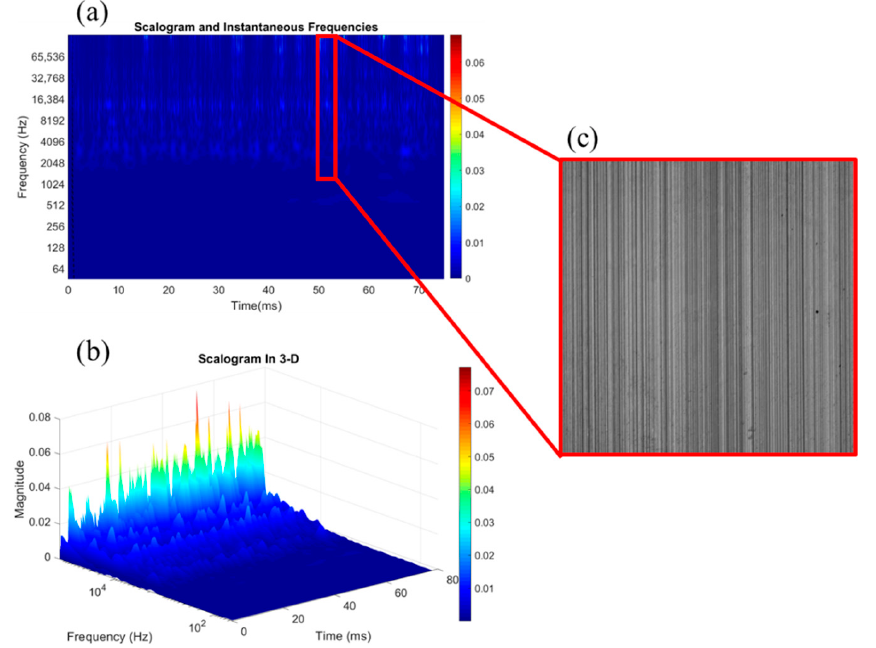
Figure 9. ( a ) 2D scalogram, ( b ) 3D scalogram, and ( c ) surface image for 1 µm depth of cut at 60 m/min.